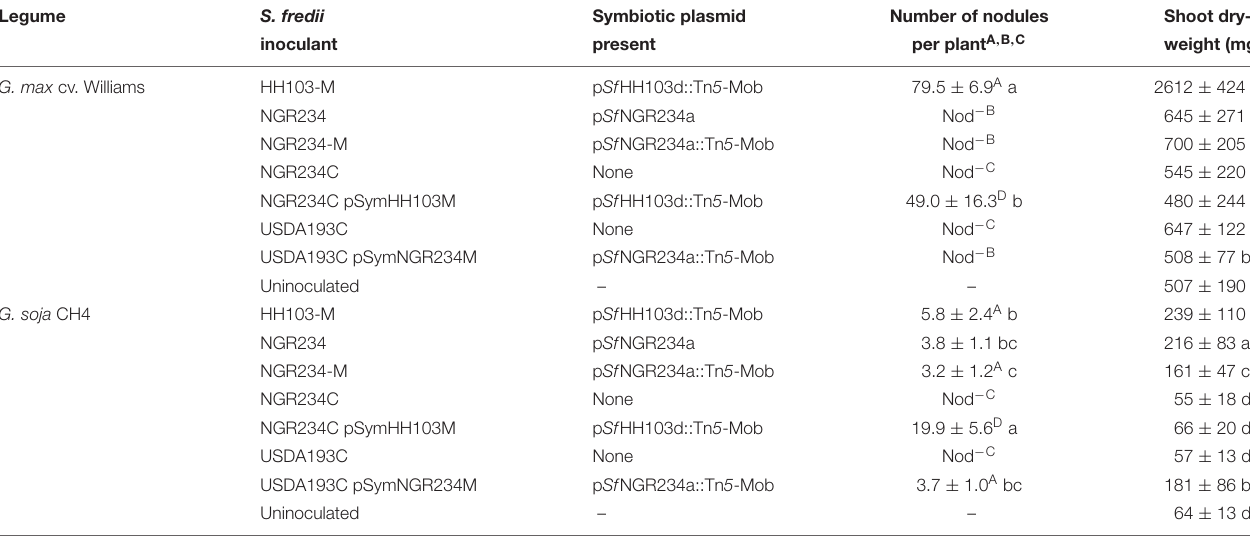
TABLE 7 | Glycine max cv. Williams 82 and G. soja CH4 responses to inoculation with S. fredii pSym-cured derivatives carrying different S. fredii pSym plasmids. Legume S. fredii Symbiotic plasmid Number of nodules Shoot dry- inoculant present per plant A , B , C weight